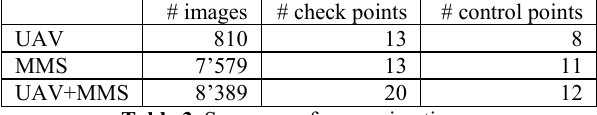
Table 3. Summary of processing time